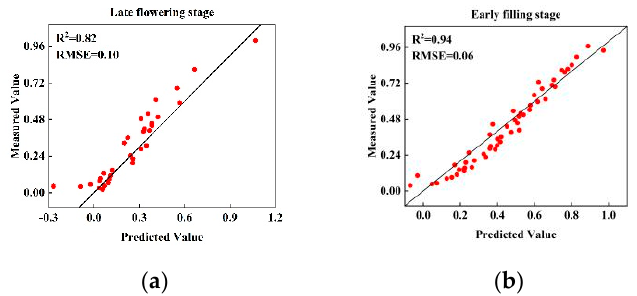
Figure 7. Evaluation of regression models at the combined stage used at the late flowering stage (a) and early filling stage (b).. and early filling stage ( b